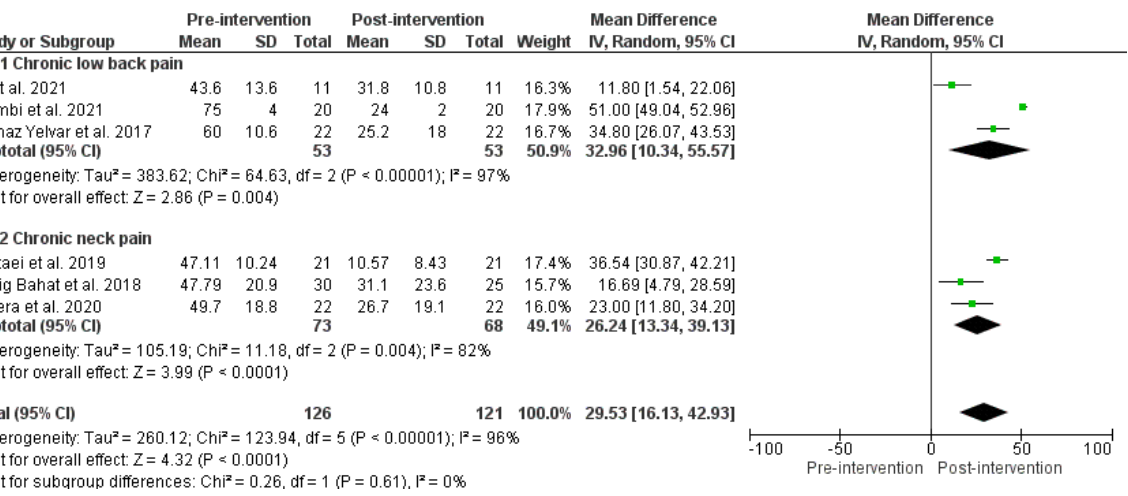
Figure 2. Effects before and after VR therapy on VAS score. Green squares represent mean difference for each study, while black rhombus represents the aggregated average of the mean differences.